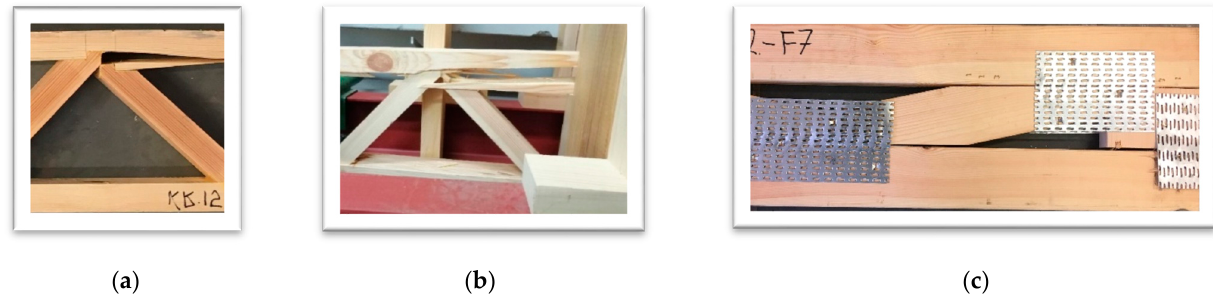
Figure 6. Failure images of tested lattice beams: ( a ) UPP1; ( b ) UPP2; ( c ) industrial.